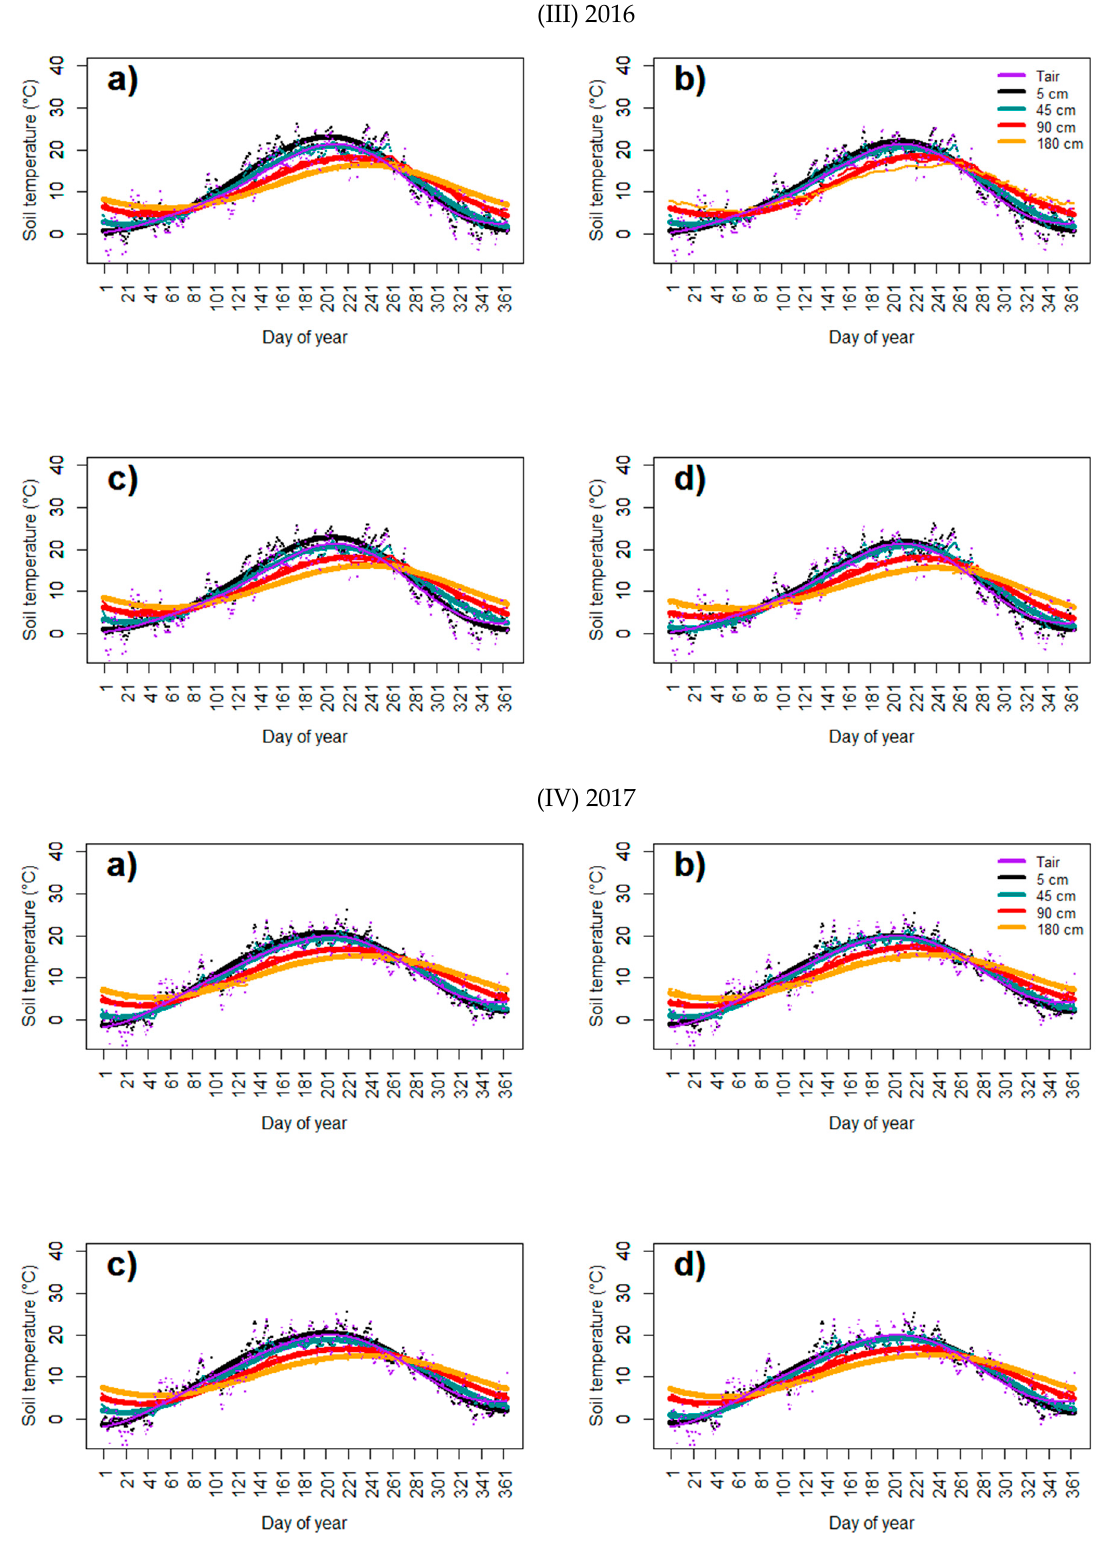
Figure 1. Fitted annual soil thermal waves of different treatments at various soil depths over the studied years. ( a ) P0N0 ( b ) P0N1 ( c ) P1N0 and ( d ) P1N1.